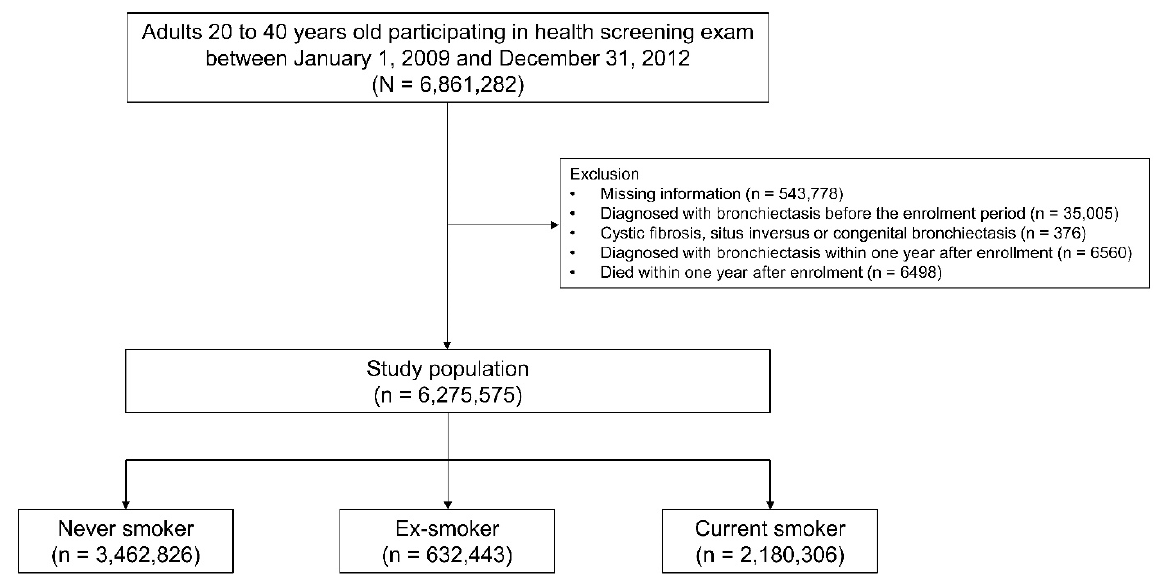
Figure 1. Flow chart of the study population.